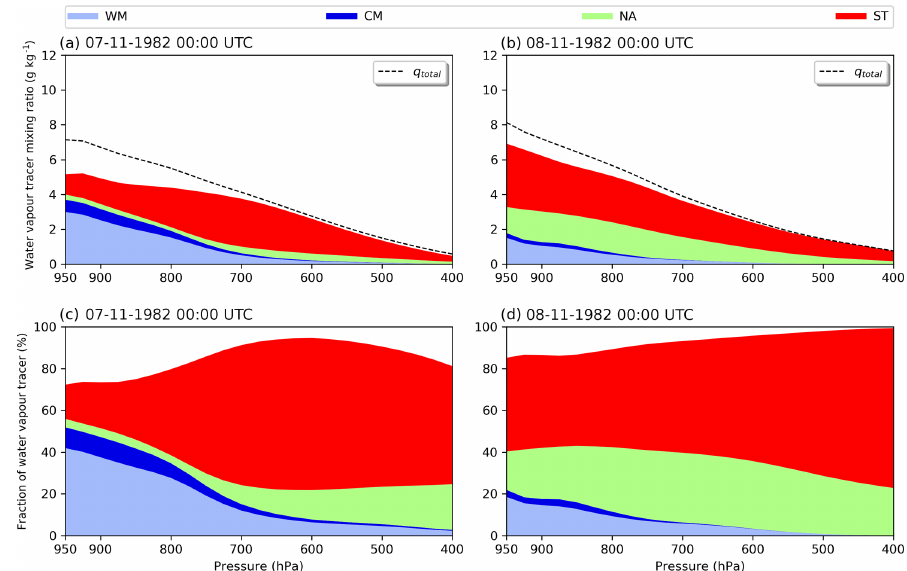
Figure 11. Similar to Fig. 6, but for 7 November (a, c) and 8 November (b, d) at 00:00UTC. The analysis is now over region 2 in Fig. 2b.